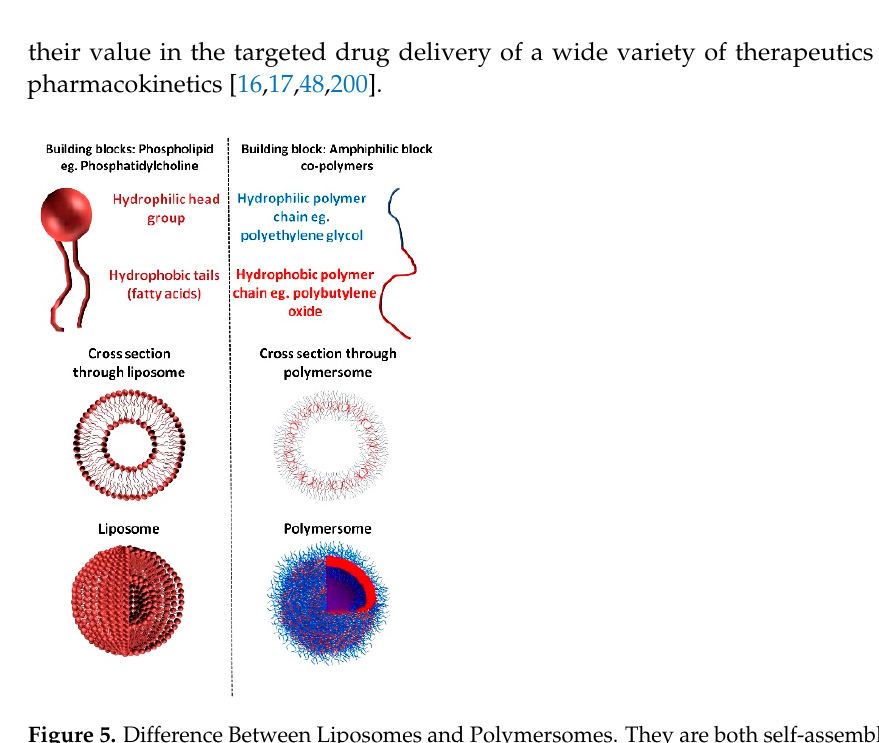
Figure 5. Difference Between Liposomes and Polymersomes. They are both self-assembled structures with different types of building blocks. Liposomes are made of phospholipids. While, polymersomes are made of block-copolymers (Reproduced with permission from [201]; Copyright Elsevier,